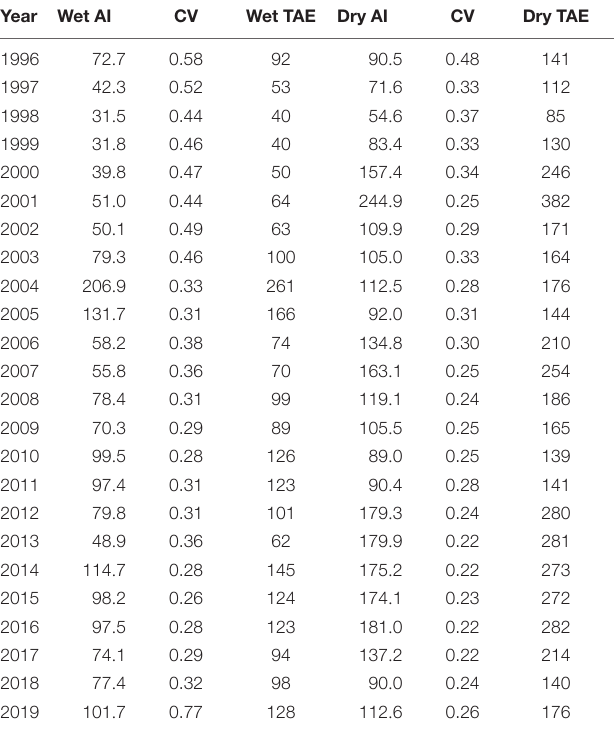
TABLE 2 | Annual abundance indices (Al) by season, and their associated total abundance estimates